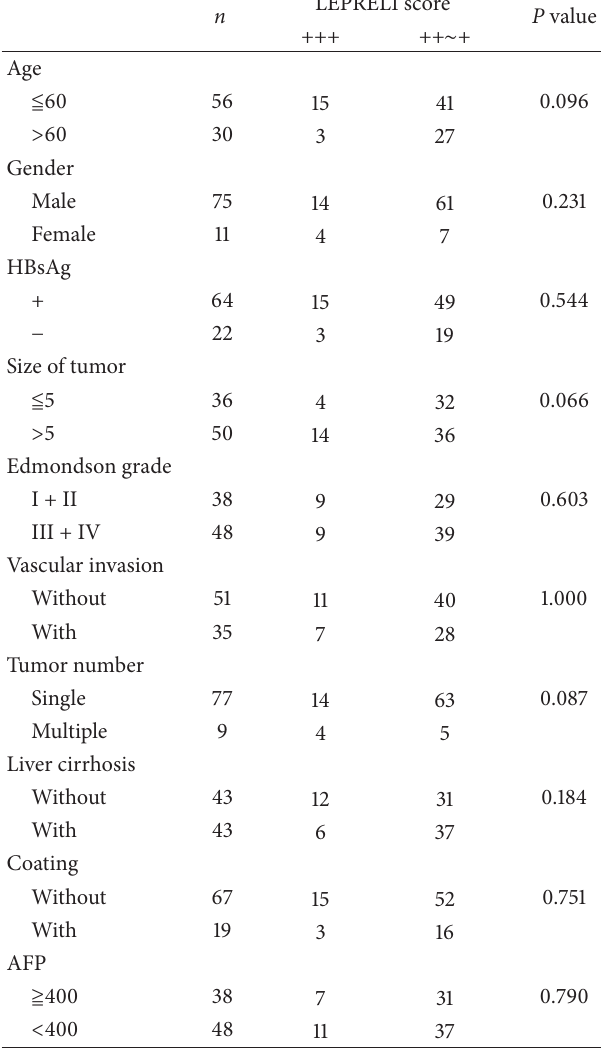
Table 1: Clinicopathological characteristic of HCC